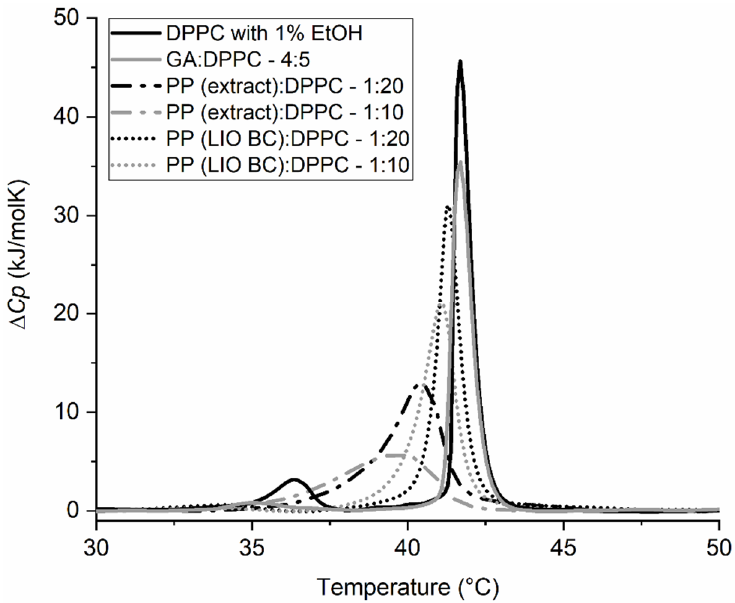
Figure 1. DSC thermograms of 1,2-dipalmitoyl- sn -glycero-3-phosphatidylcholine (DPPC) liposomes in 20 mM HEPES (pH = 7.0) buffer with 1% ethanol (EtOH), gum Arabic (GA) (negative controls), and non-encapsulated propolis (PP (extract)) or propolis encapsulated in gum Arabic by lyophilisation (PP (LIO BC)) at different w compound : w DPPC mass ratios. The mass ratio between propolis in gum Arabic inside the encapsulated powders was w propolis : w gum arabic = 1:4.